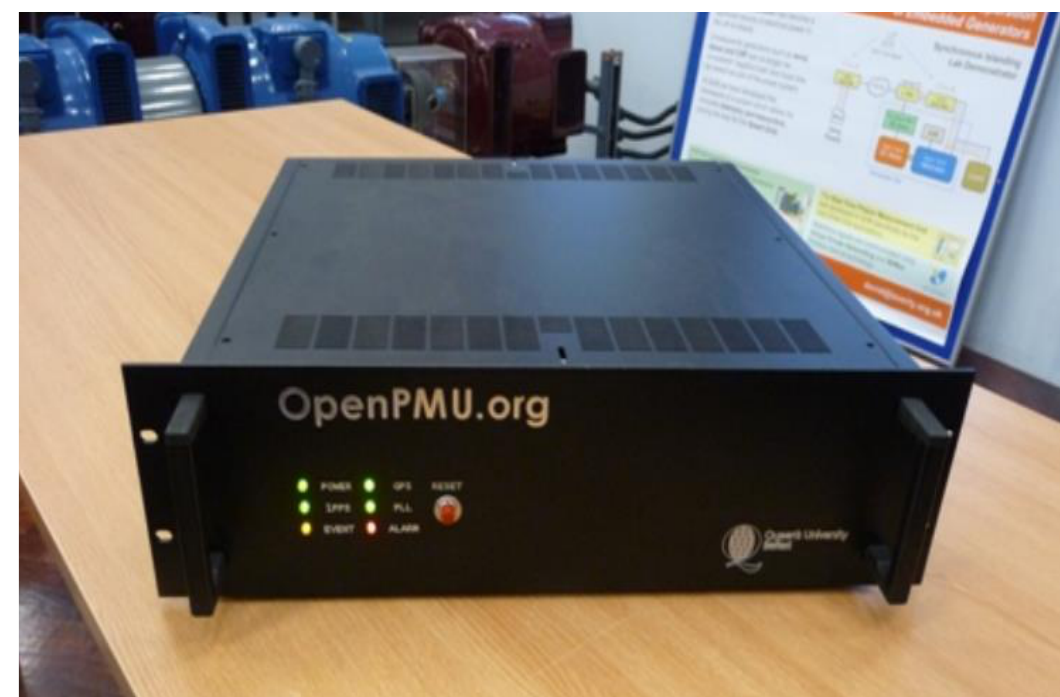
Figure 2. OpenPMU V1. Photo: Credits to National Instrument [19].